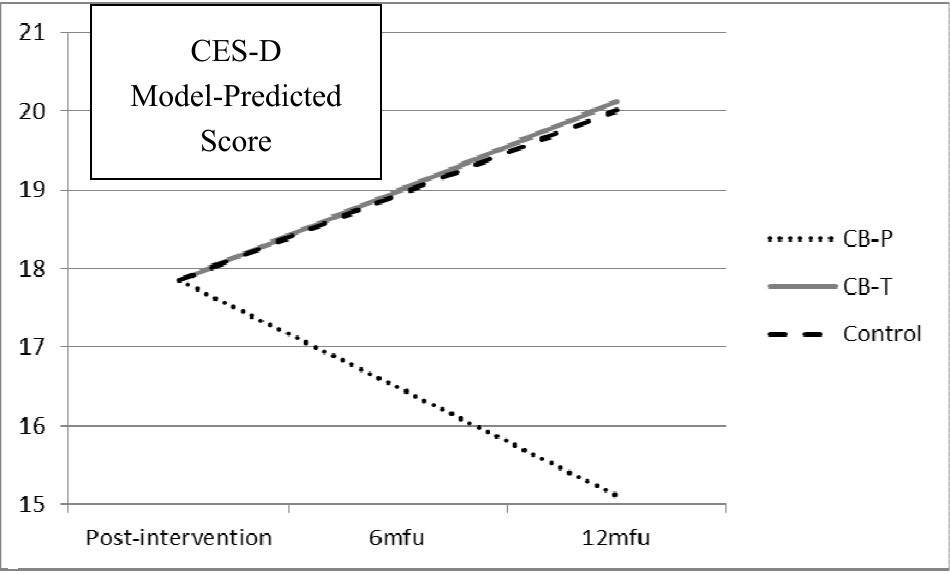
Figure 2. Girls’ model-predicted change in depression by condition. CB-P = psychologist-led intervention condition. CB-T = teacher-led intervention condition. mfu = month